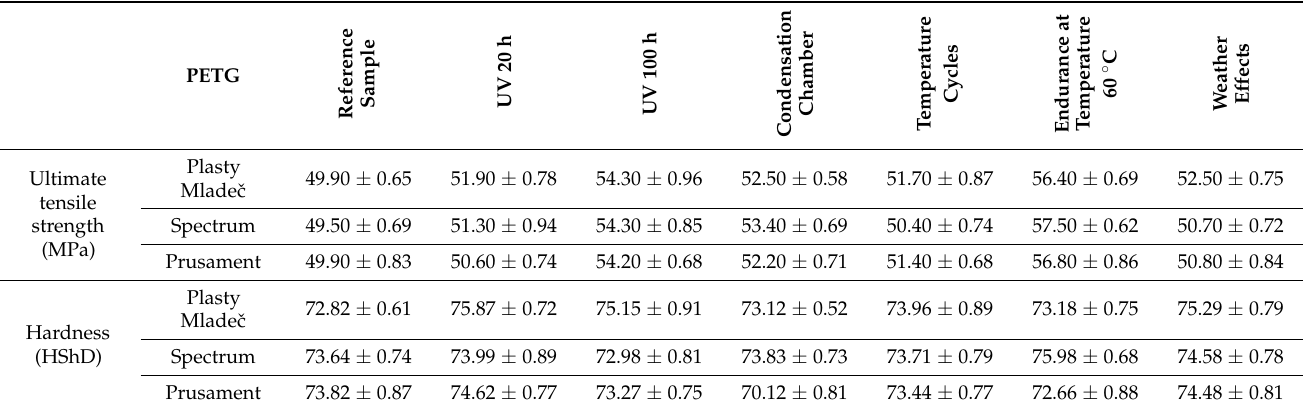
Table 6. Measured results—PETG material.